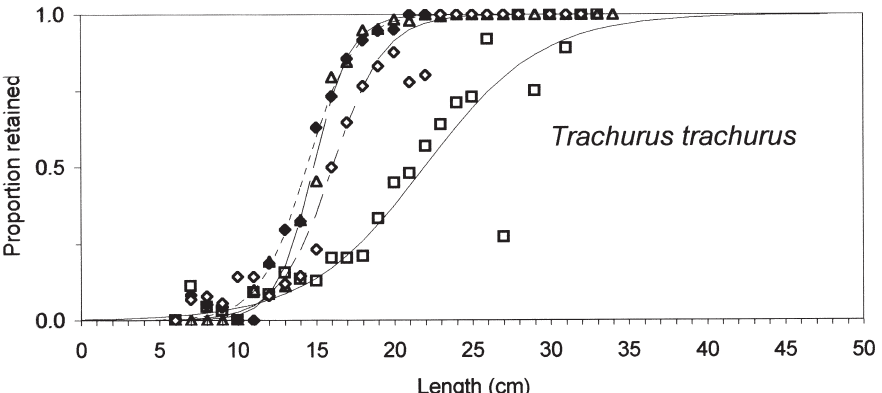
Fig. 4. – Selectivity curves for Trachurus trachurus (horse mackerel) based on pooled data, together with observed retention in the four cod ends. —- 65D; _ _ _ 70D; _ . _ . _ 80D; ____ 65S. Observed retention is expressed as black lozenges (65D), triangles (70D), white lozenges (80D) and squares